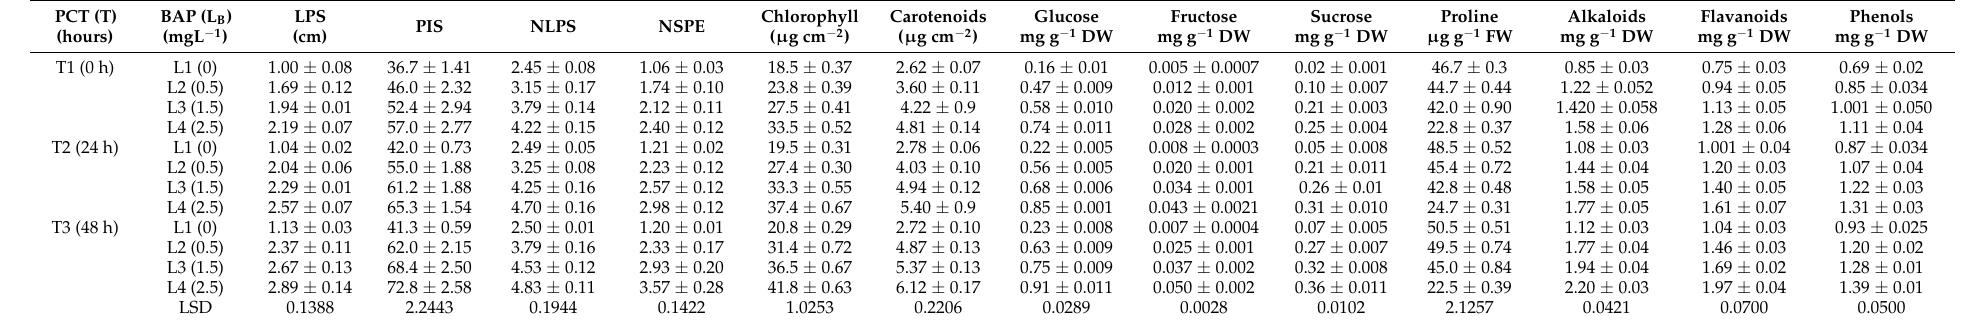
Table 5. Traits showing statistically significant ( p ≤ 0.05) difference due to interaction effect of pre-cooling regimes and BAP concentrations (T × L B ).